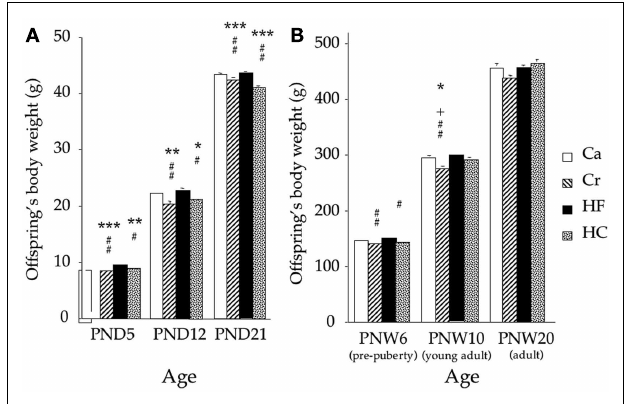
FIGURE 3 | Postnatal (PN) body weight (mean ± SEM in grams) at different times of the suckling period [PN days 1–21; (A)] and after weaning (B) at PN weeks 6, 10, and 20 in offspring from dams fed during gestation either a control diet (Ca group) ad libitum , or a restricted control (Cr group), a high-fat (HF group) or a high-carbohydrate (HC group) diet ad libitum for 6h during the light period, in addition to two normal meals given during the dark period. * p < 0.05, ** p < 0.01, and *** p < 0.001 vs Ca; # p < 0.05 and ## p < 0.01 vs HF; + p < 0.05 vs HC.